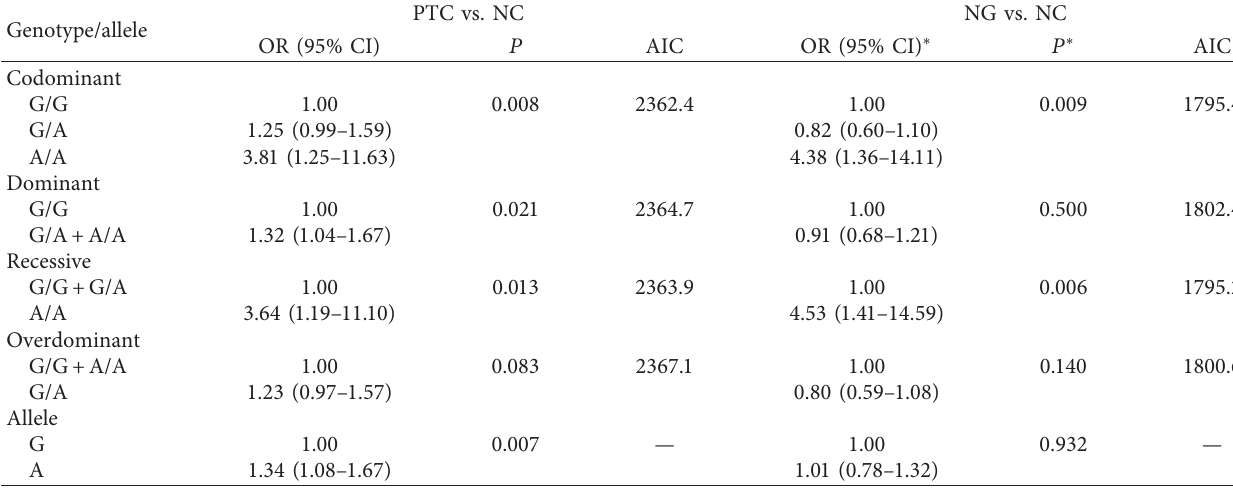
Table 4: Association between rs965513 polymorphism and PTC/NG.